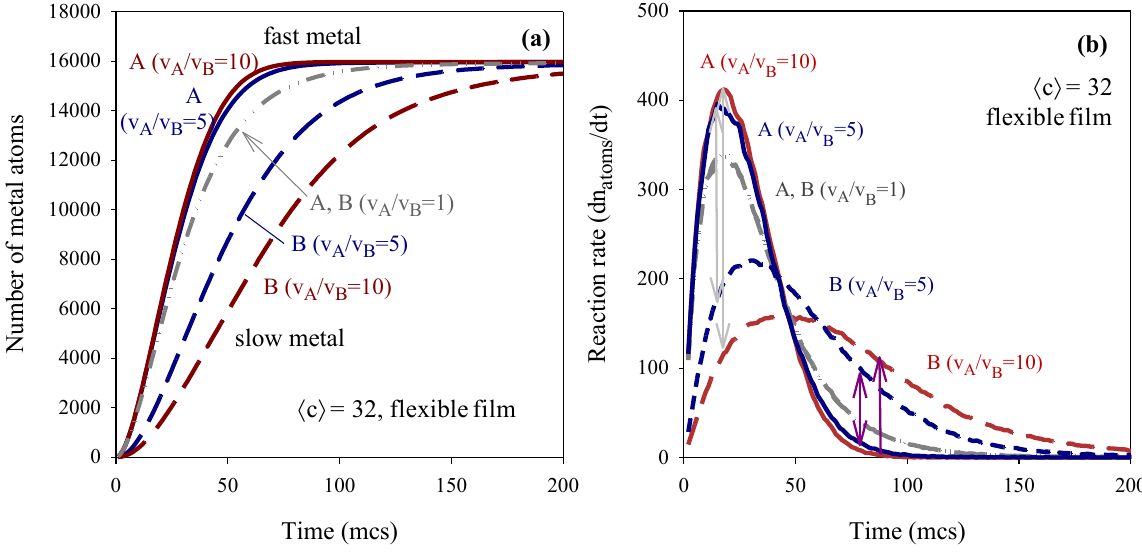
Figure 2. ( a ) Time evolution of the number of metal atoms obtained in micelles using different reduction rate ratio v A /v B = 1, 5, 10; ( b ) reaction rate vs. time. Continuous and discontinuous lines show the obtaining of fast (A) and slow (B) metals respectively. Synthesis conditions: flexible film ( k ex = 5, f = 30), average concentration  c  = 32 metal salt in a micelle. Scheme color: grey line represents v A /v B = 1; blue lines represent v A /v B = 5; red lines represent v A /v B =